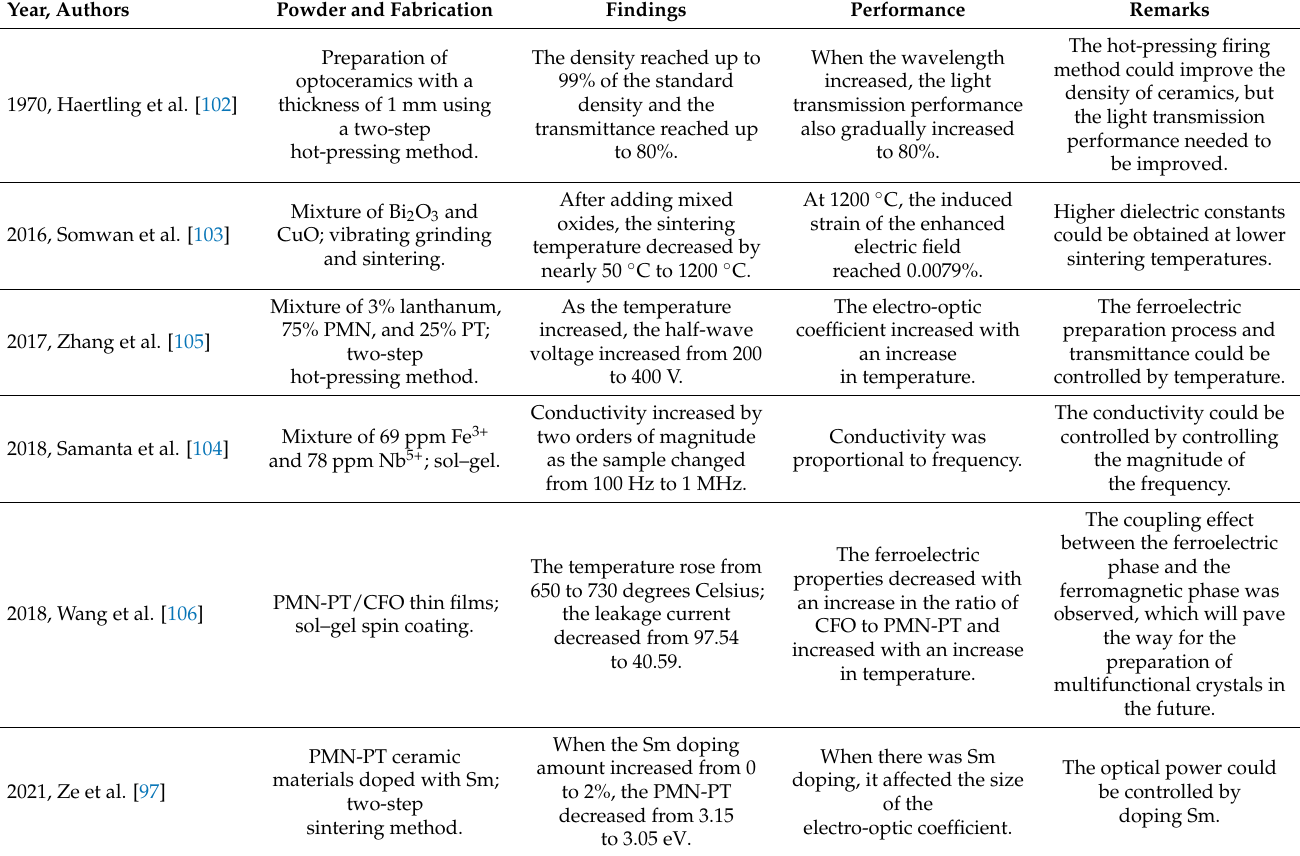
Table 3. Summary of electro-optical transparent nano-ceramics described in the text grouped